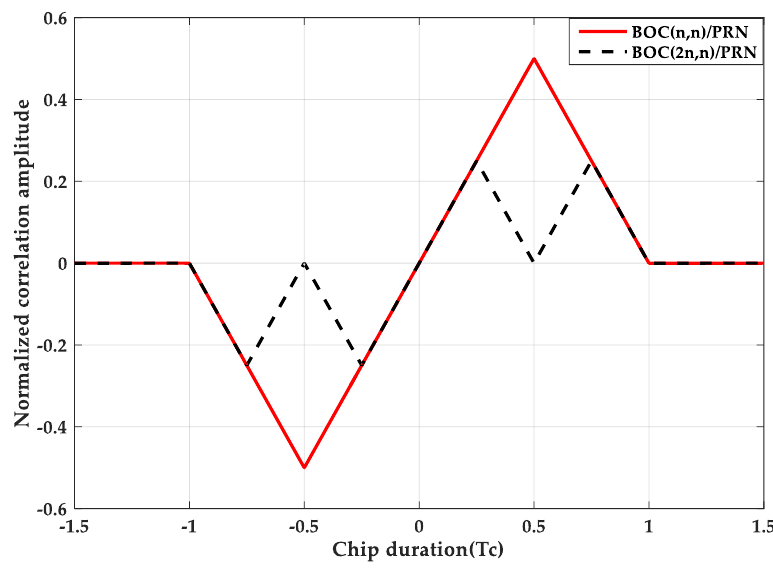
Figure 2. Cross-correlation functions.